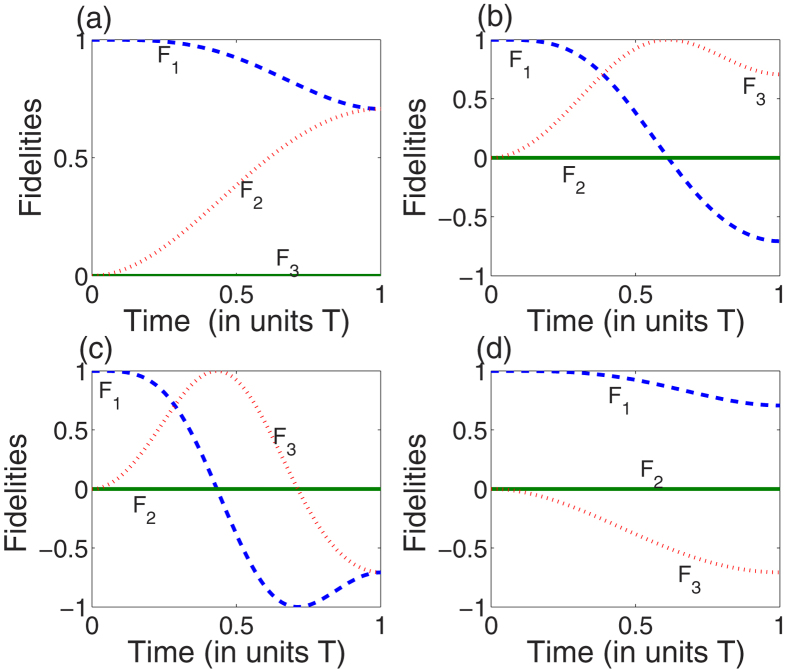
Protocol I of single-mode driving: The fidelities for states |1〉, |2〉, and |3〉 with  when: (a) ; (b) ; (c) ; (d) .